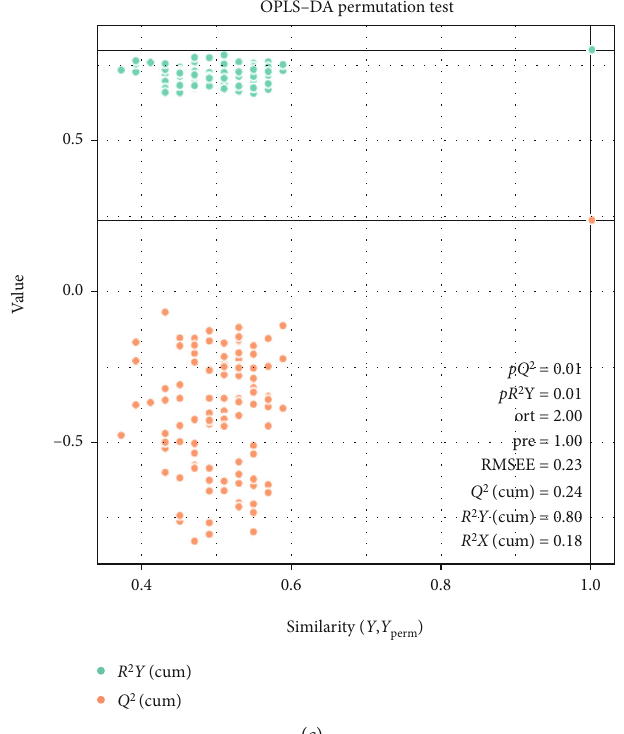
Figure 3: Metabolite pro fi le of the GDM group vs. the control group. (a) Score plot of the OPLS-DA model obtained from GDM and healthy subjects. Separation in X ð p1 Þ represents between group variation, and separation in Y (o1) represents within group variation. (b) The S -plot of OPLS-DA. (c) OPLS-DA permutation test at FDR 0.1